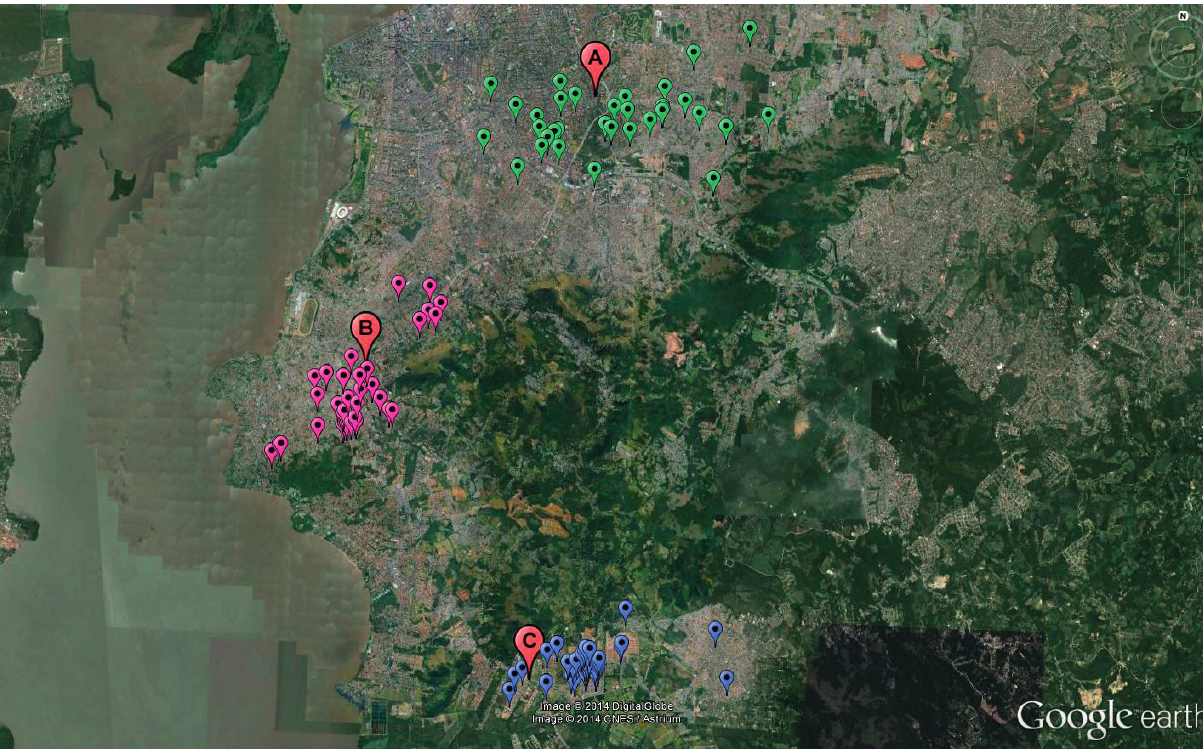
Figure 1. Subject distribution by monitoring